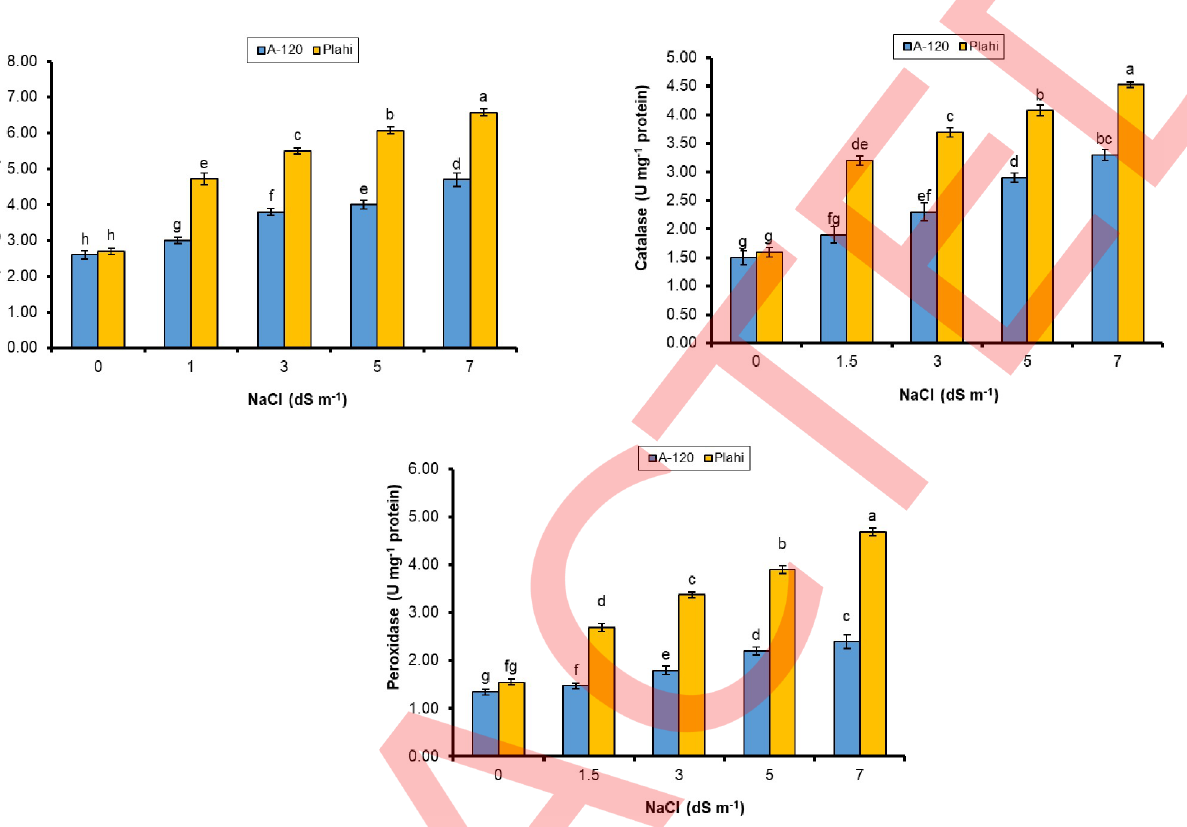
Fig 6. Effect of NaCl stress on antioxidant enzymatic activities (SOD, CAT & POD) of two chili genotypes.